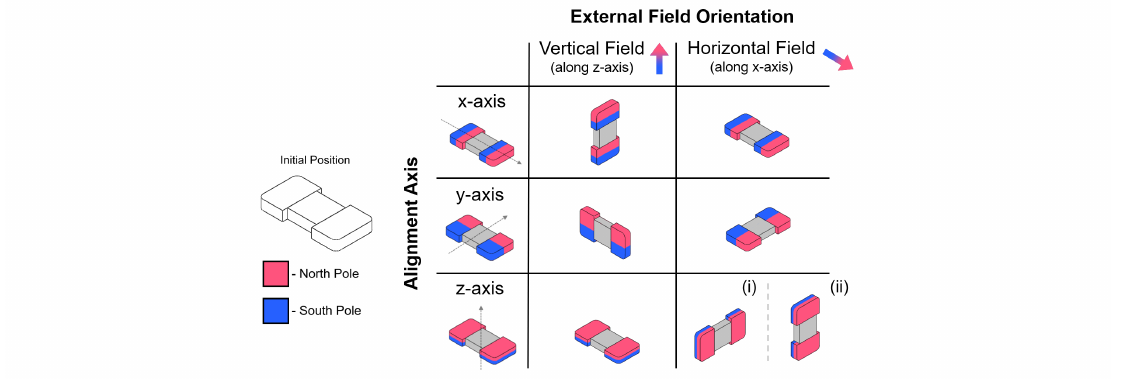
Figure 3. Equilibrium resting states of each major axis alignment configuration under horizontal and vertical external magnetic fields. Note: for z-axis alignment, both (i) and (ii) are possible under the same conditions, but (i) is in a lower energy state than (ii) and thus more likely to occur in